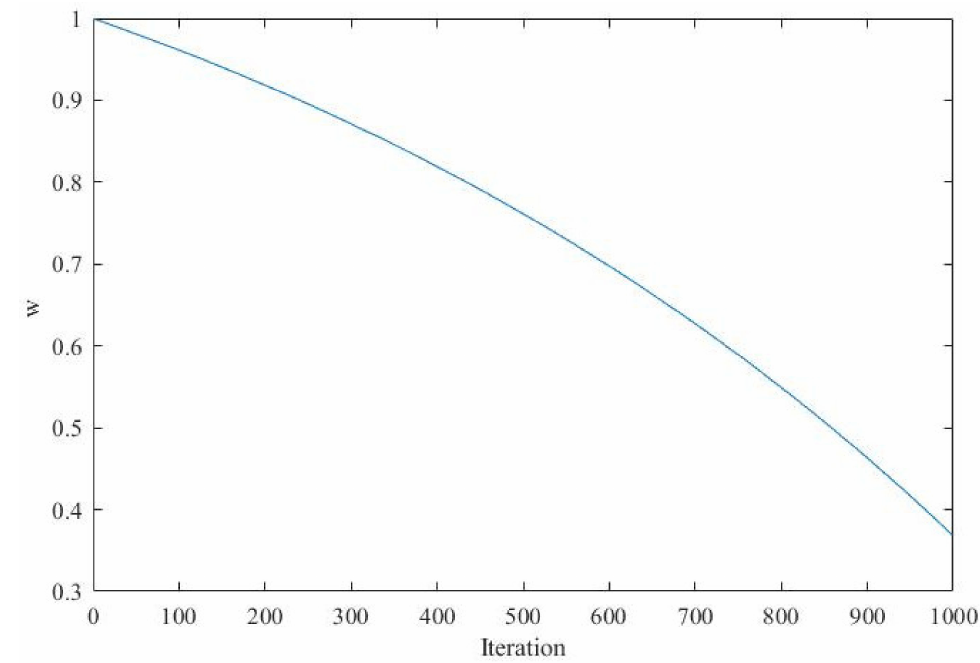
Figure 2. The changing trend of w